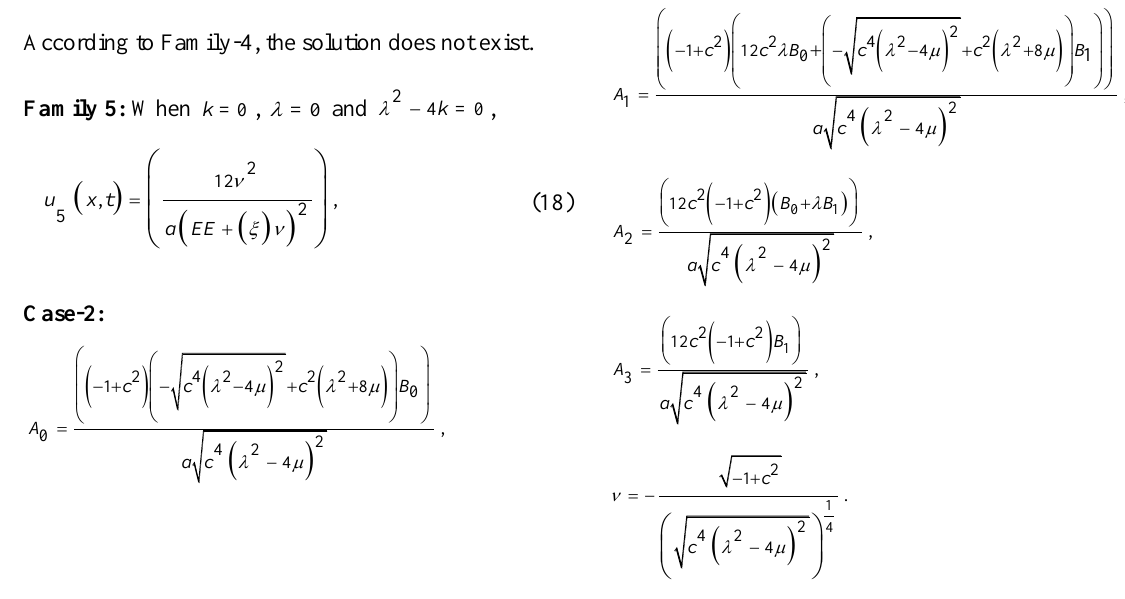
Figure-3. The 3D, density graphic and 2D surfaces of Eq. (17) in 0.5, 0, 4, 0.5, c a  = = = = 1, 0.75 EE  = = and 1 t = .